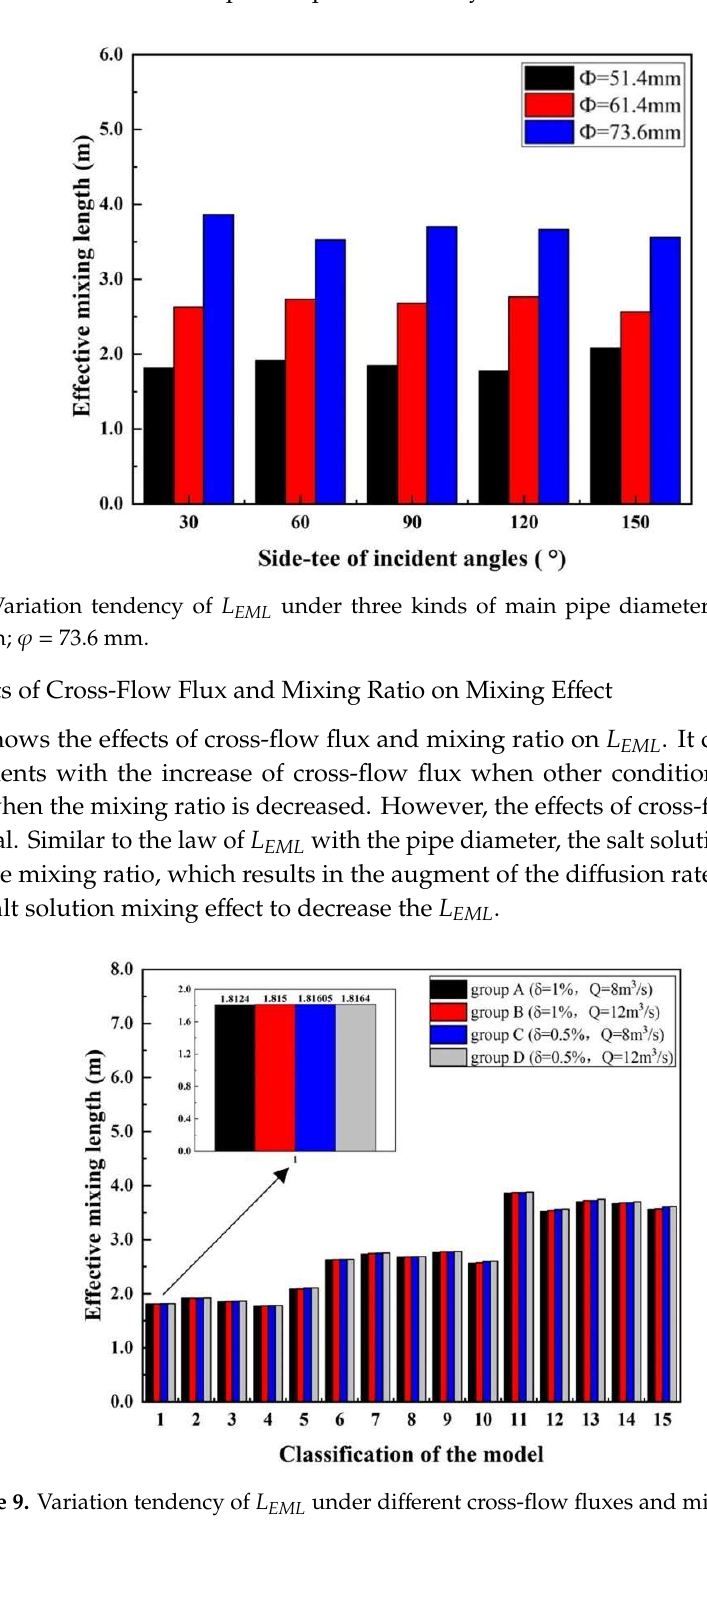
9 of 14 Figure 7. Section contour of the volume fraction of salt solution in the pipeline.